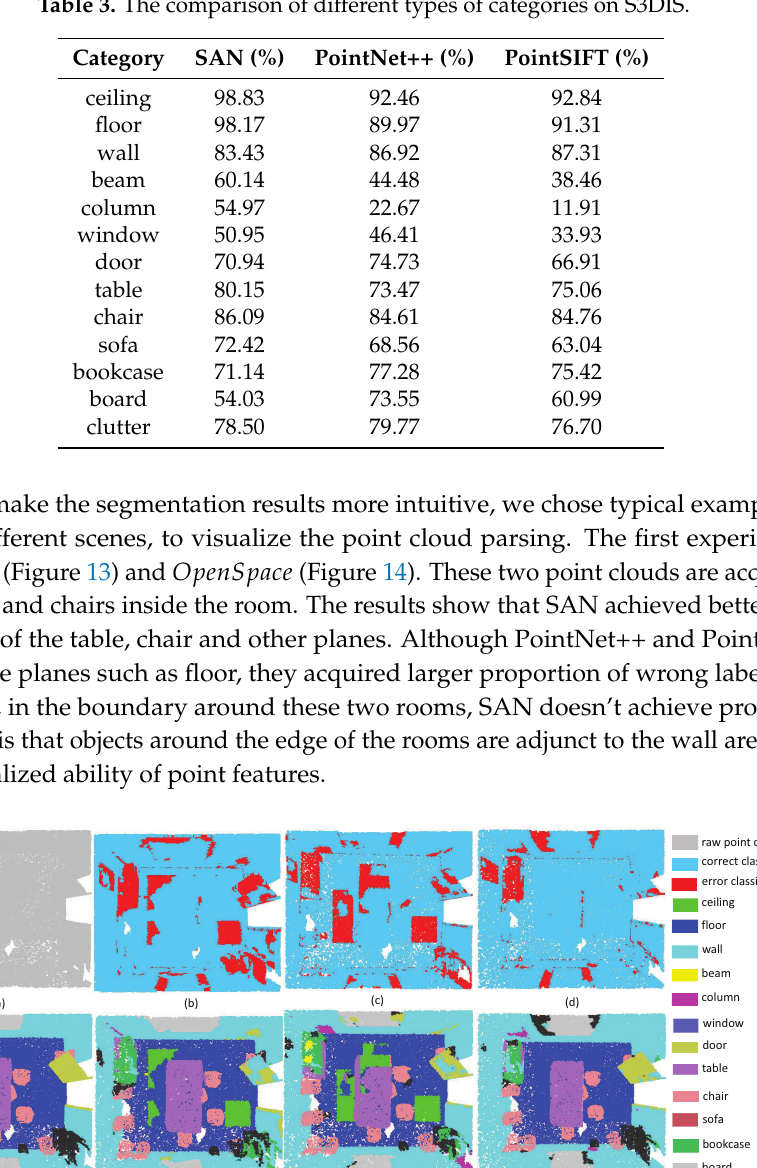
Table 3. The comparison of different types of categories on S3DIS.